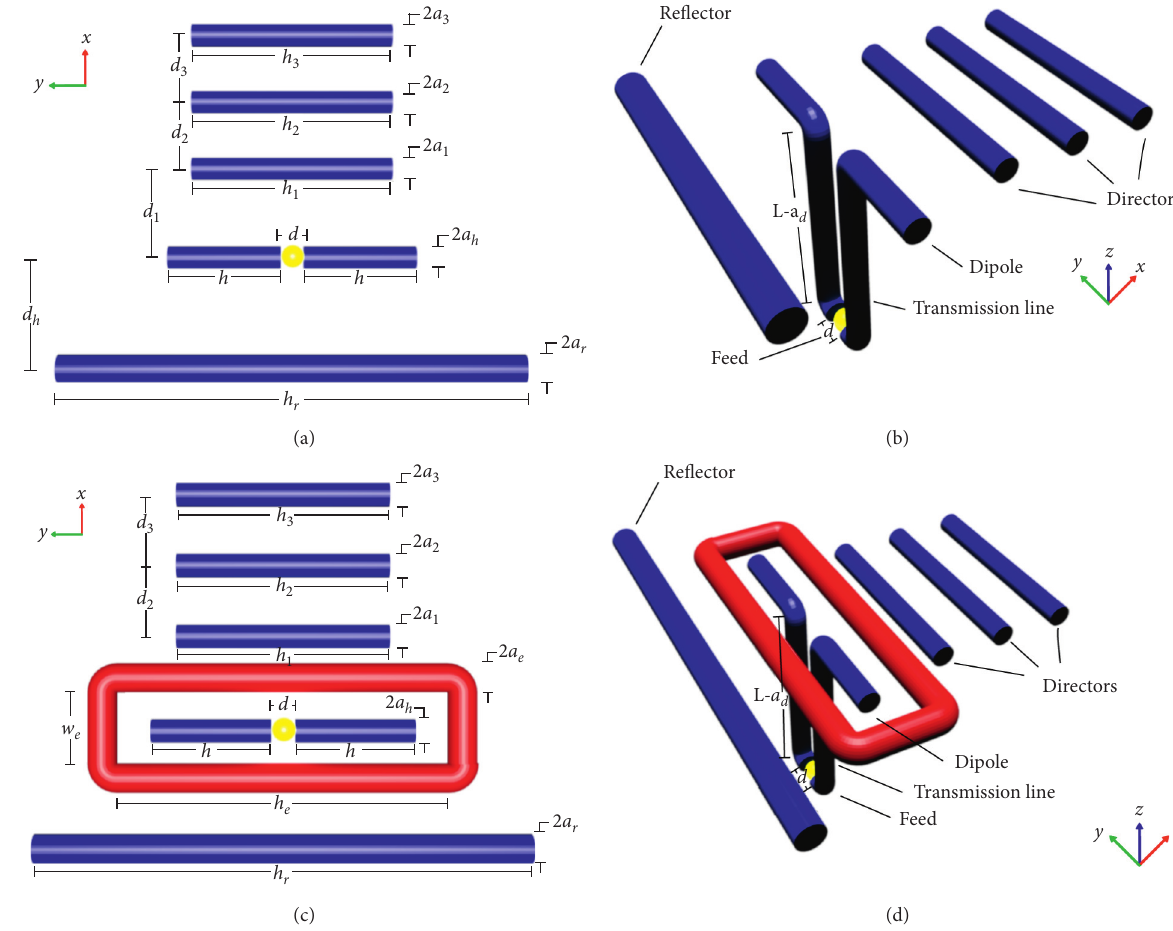
Figure 1: Geometries of the four YU nanoantennas models in study. (a) Conventional YU, (b) YU with OTL, (c) YU with loop, and (d) YU with loop and